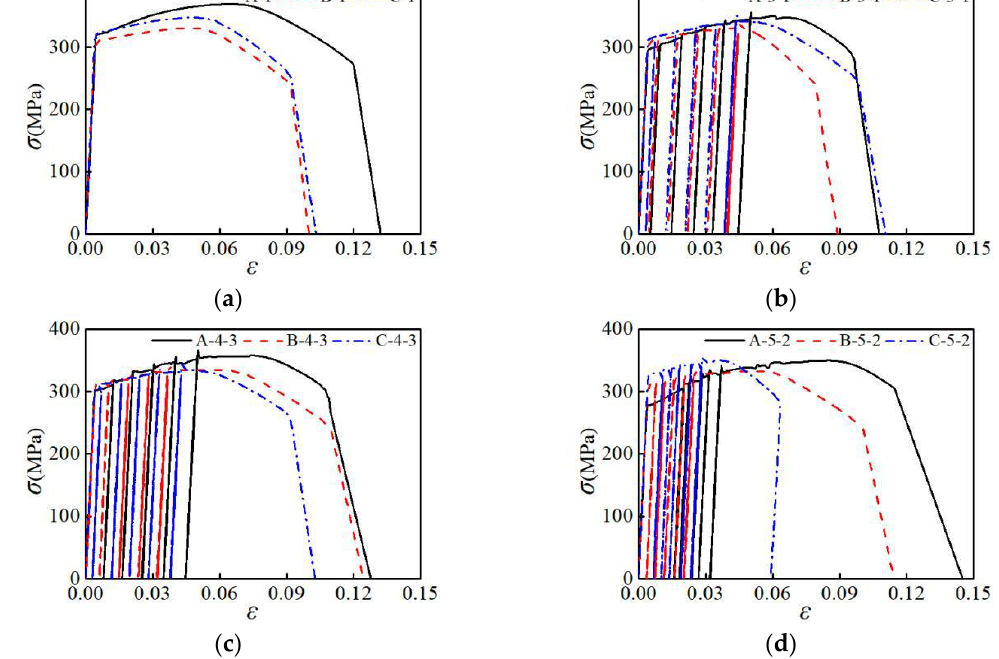
Figure 5. Influence of material type on stress-strain curve: ( a ) loading pattern NM-1; ( b ) loading pattern NM-3-1; ( c ) loading pattern NM-4-3; ( d ) loading pattern NM-5-2.